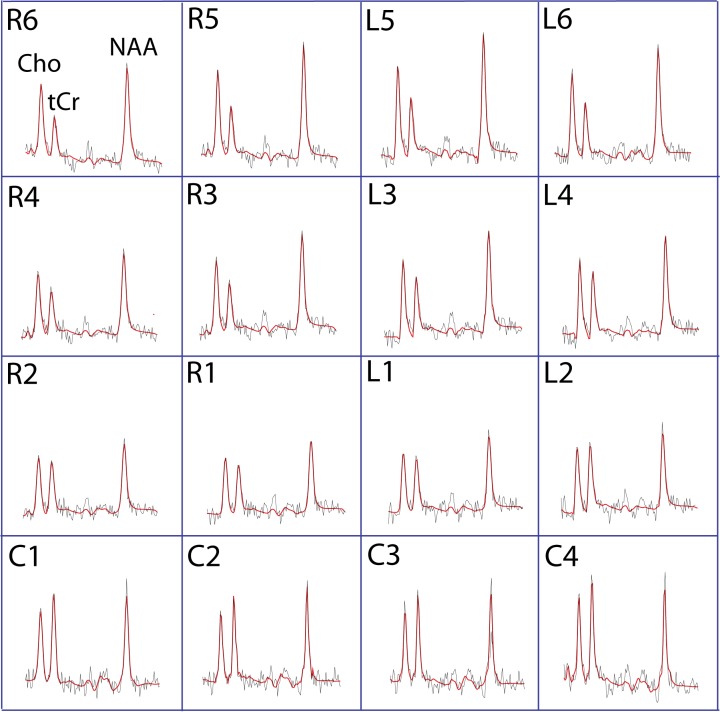
Spectra from 16 voxels in a 29 year old high fatigue patient.The red lines show the LCModel fit for each spectrum and the black lines are the raw spectral line.